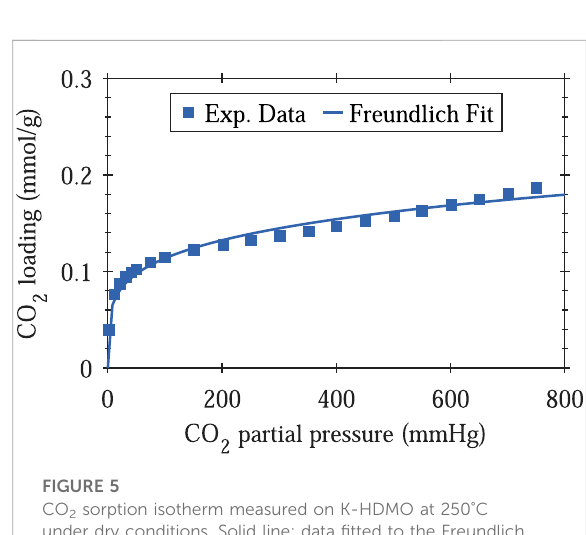
FIGURE 4 Experimental CO conversion over Steam-to-Gas ratio in the feedfor theCu/ZnO/Al 2 O 3 catalyst.Catalyst mass: 0.5 g,pressure: 8bar, feed fl ow rate:2000 ml min − 1 ,feedvolume fraction CO:0.1. Catalyst is homogeneously mixed with inert material (SiC) in the fi rst quarter of the reactor. Solid lines: data fi tted according to the empirical model (Eq. 4) with kinetic parameters from Table 3. Dashed lines: temperature-dependent thermodynamic equilibrium.